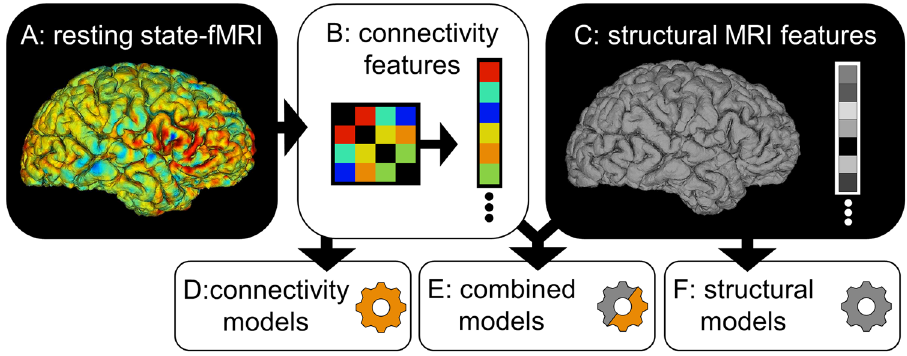
Figure 5. Combinations of derived features used by the predictive models evaluated in this study. ( A ) The rsfMRI was transformed into a symmetric connectivity matrix for each atlas. ( B ) Upper triangular elements of matrix were flattened into a 1D vector. ( C ) The sMRI was transformed into a vector of cortical and subcortical ROI volumes and cortical thickness features. Different combinations of fMRI and sMRI features were compared: In ( D ) the connectivity matrix vector is used as the sole input for the predictive model, in ( E ) both anatomical and connectivity derived feature vectors are concatenated and used, while in ( F ) the anatomical features are used as the sole input for the predictive model 62,64